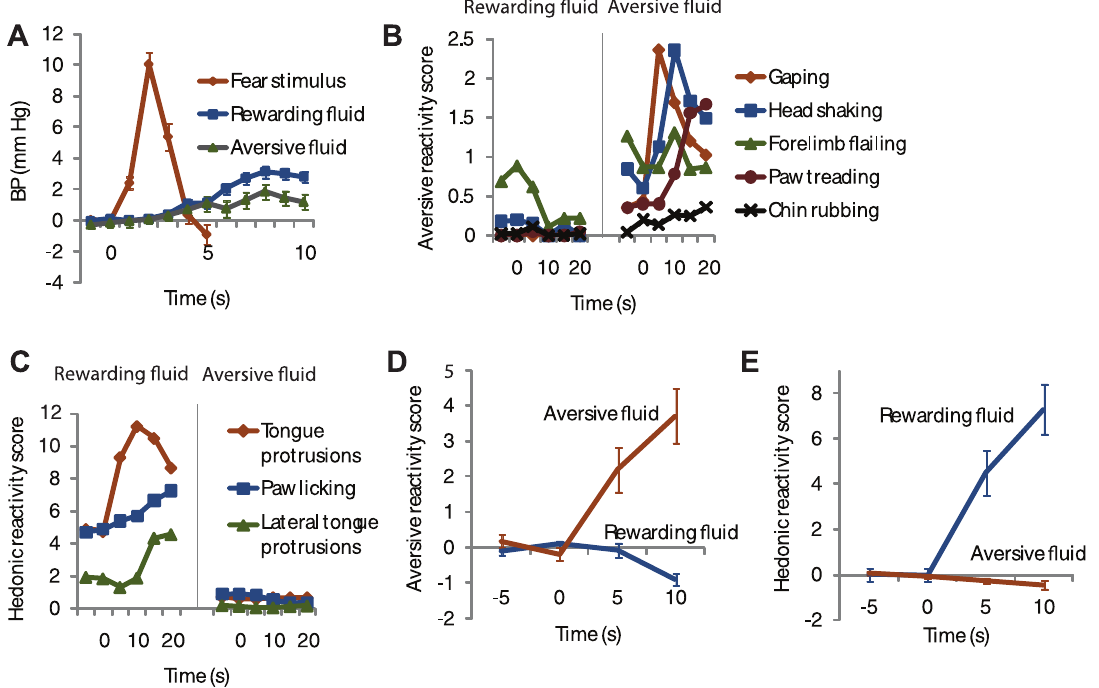
Figure 2. Blood pressure and behavior during the recording sessions. ( A ) Change in blood pressure during fear CS, rewarding fluid infusion, and aversive fluid infusion (n=39 sessions). ( B ) Mean of individual types of aversive taste reactivity responses during rewarding and aversive fluid infusions. (n=45 sessions). ( C ) Mean of individual types of positive hedonic taste reactivity responses during rewarding and aversive fluid infusions. (n=45 sessions). ( D ) Change in aversive taste reactivity responses shown in ( B ) (n=45 sessions). ( E ) Change in positive hedonic taste reactivity responses shown in ( C ) (n=45 sessions). Values represent mean + / 2 standard error of the mean.